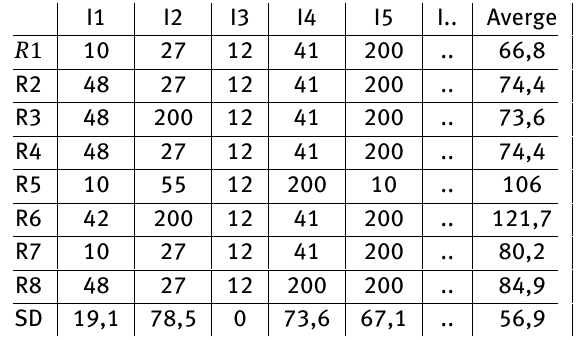
Table 5: The iterations of matching of all robots in P 2 for some test images revealing their different